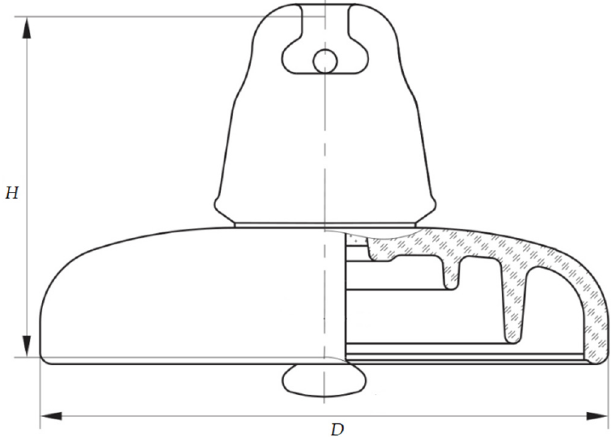
Figure 2. Size parameter of porcelain insulator U 160 BL.